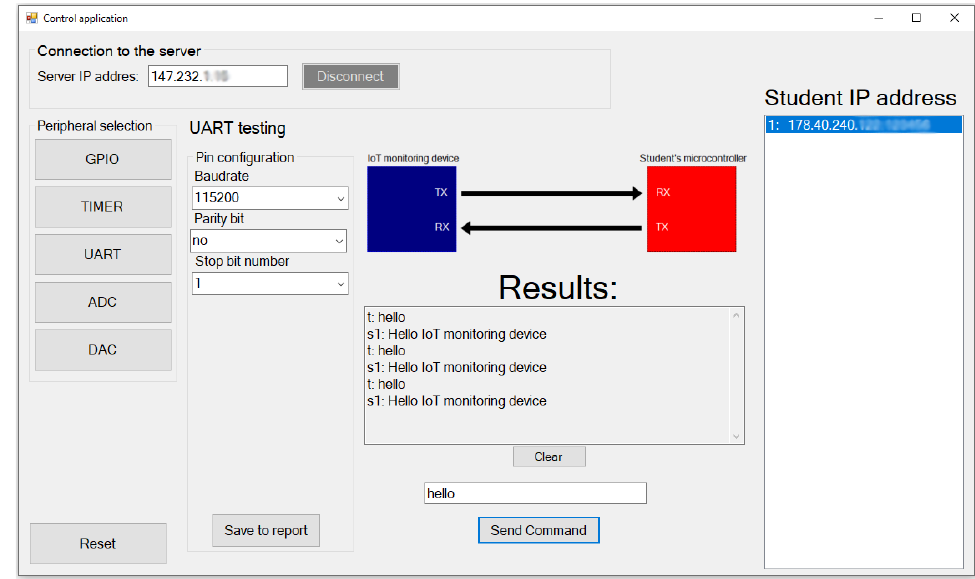
Figure 12. UART peripheral testing. Communication took place on baud rate 115200 without parity bit and one STOP bit.